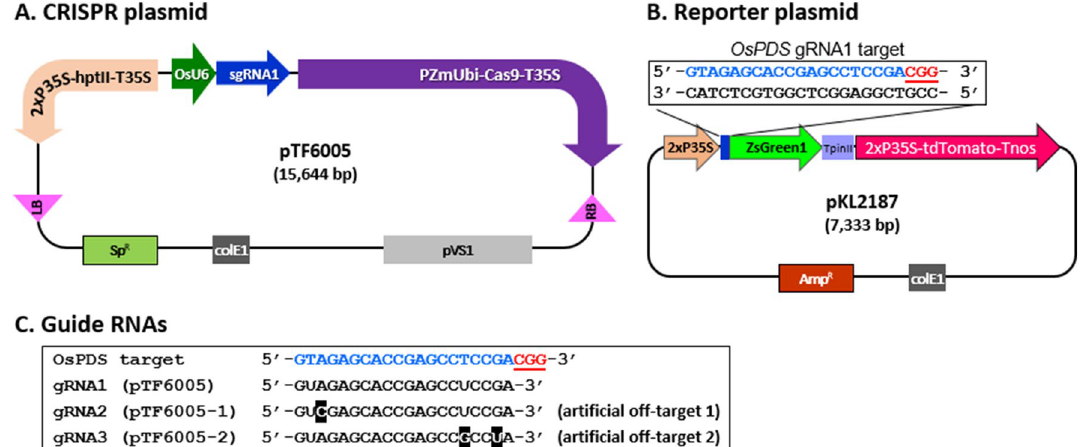
Figure 5. Schematic representation of two plasmids used for the evaluation of CRISPR reagents. ( A ) CRISPR plasmid pTF6005 28 that carries a Cas9 expression cassette under the control of maize ubiquitin promoter and Cauliflower Mosaic Virus (CaMV) 35S terminator (T35S); OsPDS gRNA1 is regulated by OsU6 promoter; hygromycin resistance gene ( hpt II ) is driven by 2 × CaMV 35S promoter (P35S) and terminated by T35S. RB, T-DNA right border; LB, T-DNA left border; Sp R , spectinomycin resistance gene; ColE1 ori, high copy number origin of replication for E. coli ; pVS1, origin of replication from plasmid VS1 for Agrobacterium . ( B ) The reporter plasmid pKL2187 has genes for the red fluorescent protein tdTomato and the green fluorescent protein ZsGreen1. Transcription of the tdTomato gene is driven by a 2X P35S and terminated by an Agrobacterium nopaline synthase terminator (Tnos). The encoded tdTomato protein has an SV40 nuclear localization signal at the N terminus. Transcription of the ZsGreen1 gene is driven by a 2X P35S promoter and terminated by a potato protease inhibitor II terminator (TpinII). The translation start codon is preceded by a TMV Ω translational enhancer and is immediately followed by the target sequence of the OsPDS-gRNA1 expressed from pTF6005. The open reading frame for the flexible peptide linker 2X (GGGGS) and ZsGreen1 is out-of-frame by 1-bp with the start codon and is not translated; however, indel mutations at the gRNA target site can bring the ZsGreen1 gene in-frame and restore green fluorescence. Amp R , ampicillin resistance gene. The plasmid pKL2188 is identical to pKL2187 except that the ZsGreen1 gene is in-frame with the start codon. Blue letters, gRNA target sequence; underscored red letter, PAM sequence. ( C ) Three guide RNAs tested for editing efficiency. All gRNAs were driven by OsU6 promoter in the CRISPR plasmid shown in ( A ). gRNA1, on-target gRNA; gRNA2 and gRNA3, artificial off-target gRNAs with one or two mismatches (white letters in black